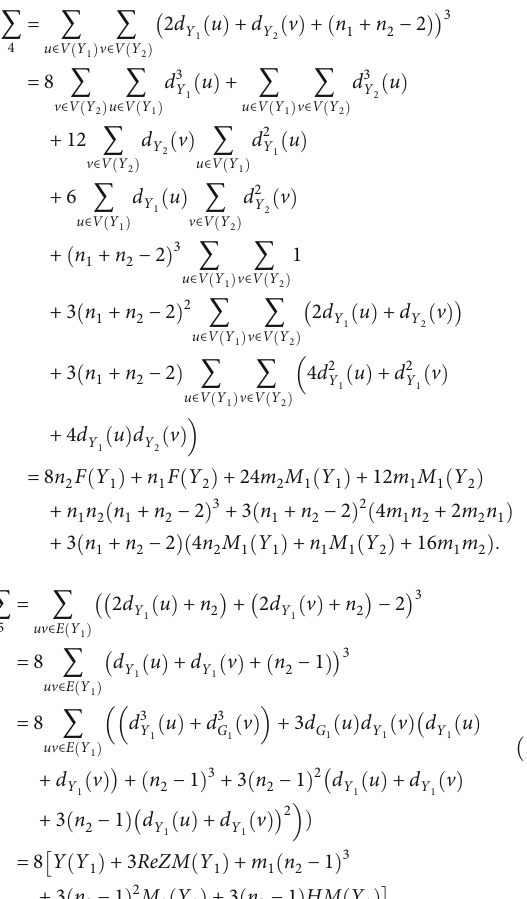
Table 8: The degree distribution of Y